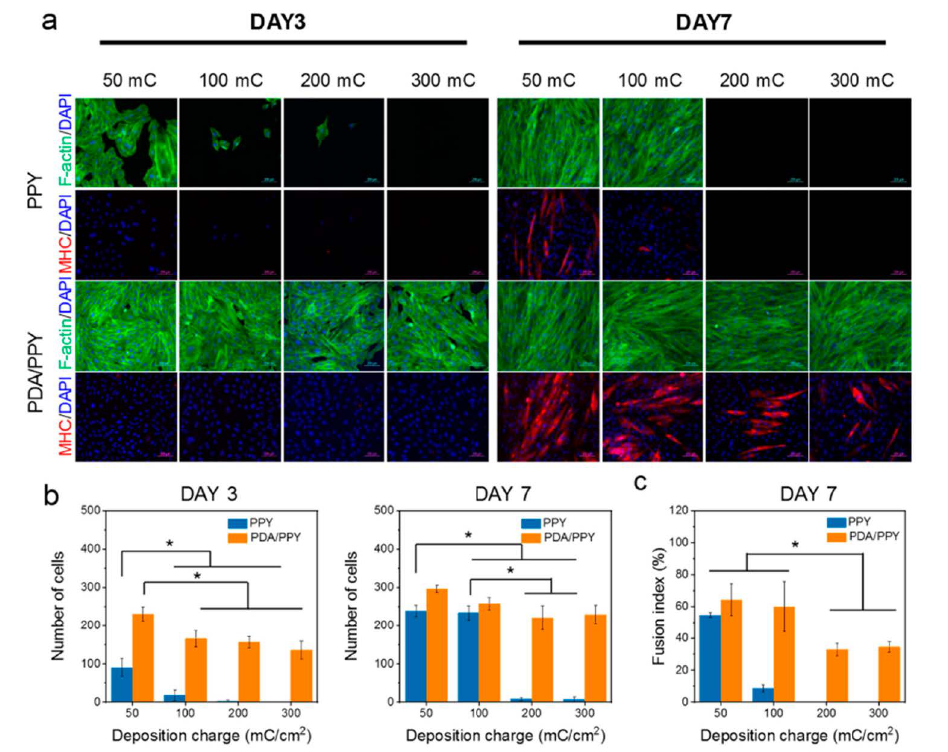
Figure 5. In vitro C2C12 myoblast growth and differentiation on the PPY- and PDA/PPY-modified electrodes. ( a ) Immunofluorescence images of C2C12 cells cultured on PPY and PDA/PPY samples for 3 and 7 days. Cells were stained for F-actin (green), MHC (red), and nuclei (blue). Scalebars = 200 µ m. ( b ) Number of cells at day 3 and day 7. ( c ) Fusion indices of the C2C12 myoblasts at day 7. For image analysis, images were randomly taken from multiple samples and analysed. n = 5. Reprinted with permission from Reference [76]. Copyright (2018) American Chemical